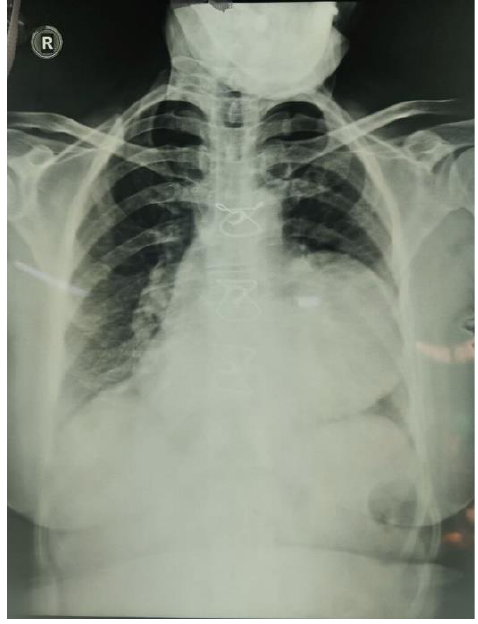
Figure 1 . Chest - Xray demonstrating left lower zone mass.